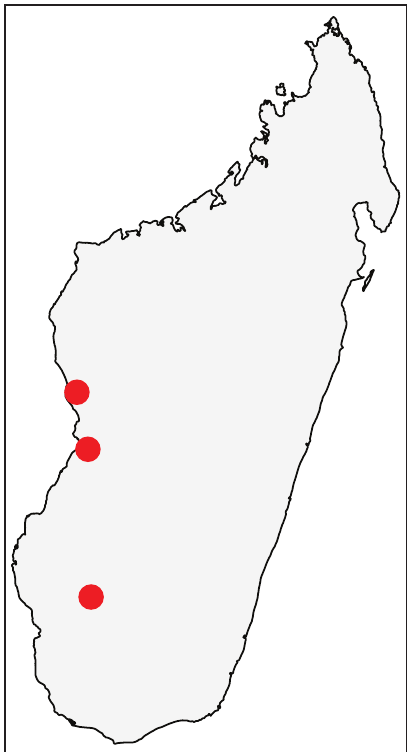
Figures 13. Geographic distribution of Nesomyrmex brevicornis sp. n.. The known localities of N. brevi- cornis sp. n. in